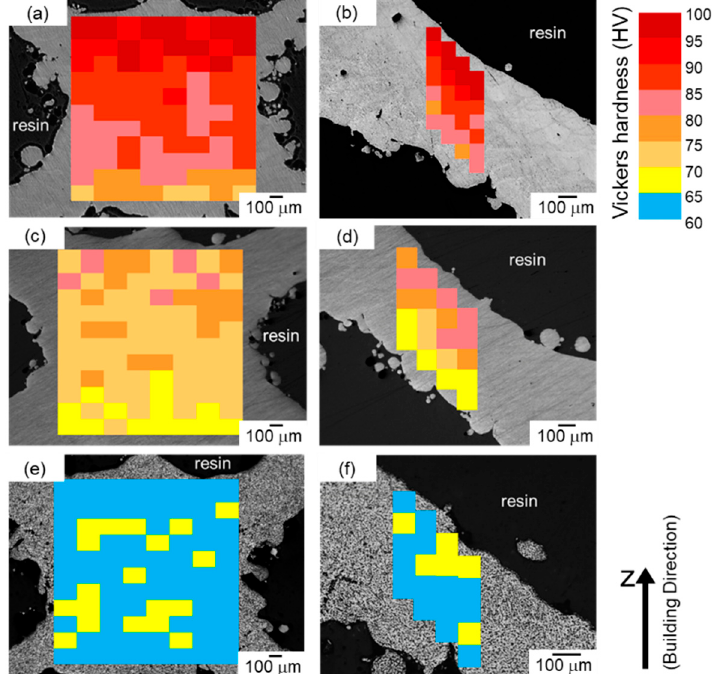
Figure 15. Microhardness maps indicating local hardness of various areas within ( a , c , e ) node portion and ( b , d , f ) strut portion of the lattice specimen; ( a , b ) as-manufactured, ( c , d ) annealed at 300 ° C for 2 h, and ( e , f ) solution heat treated at 530 ° C for 6